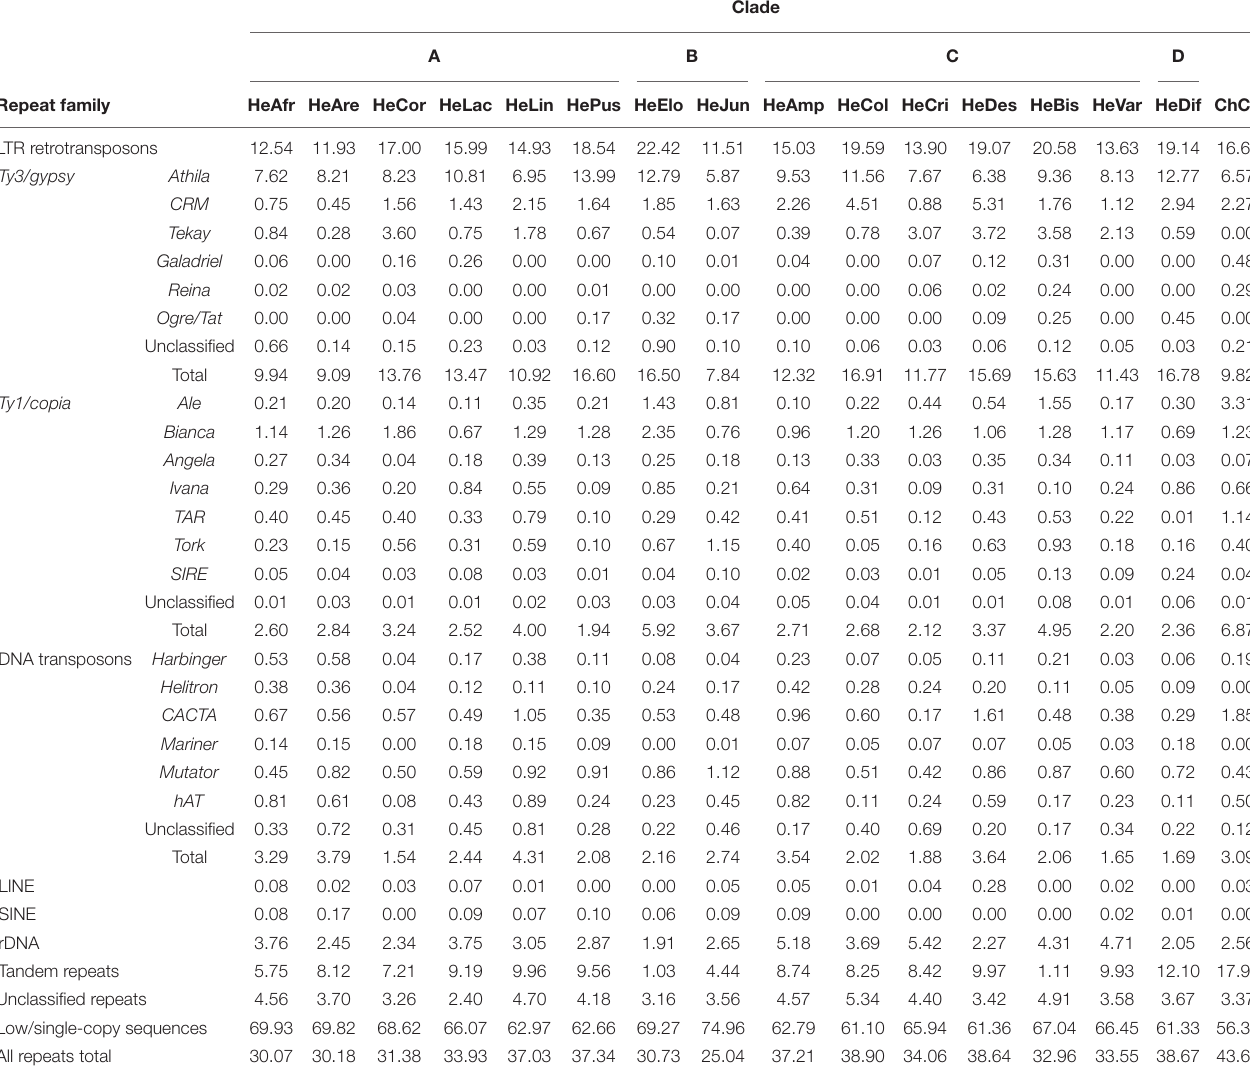
TABLE 2 | Detailed classification of repetitive elements and their genome proportions (%).